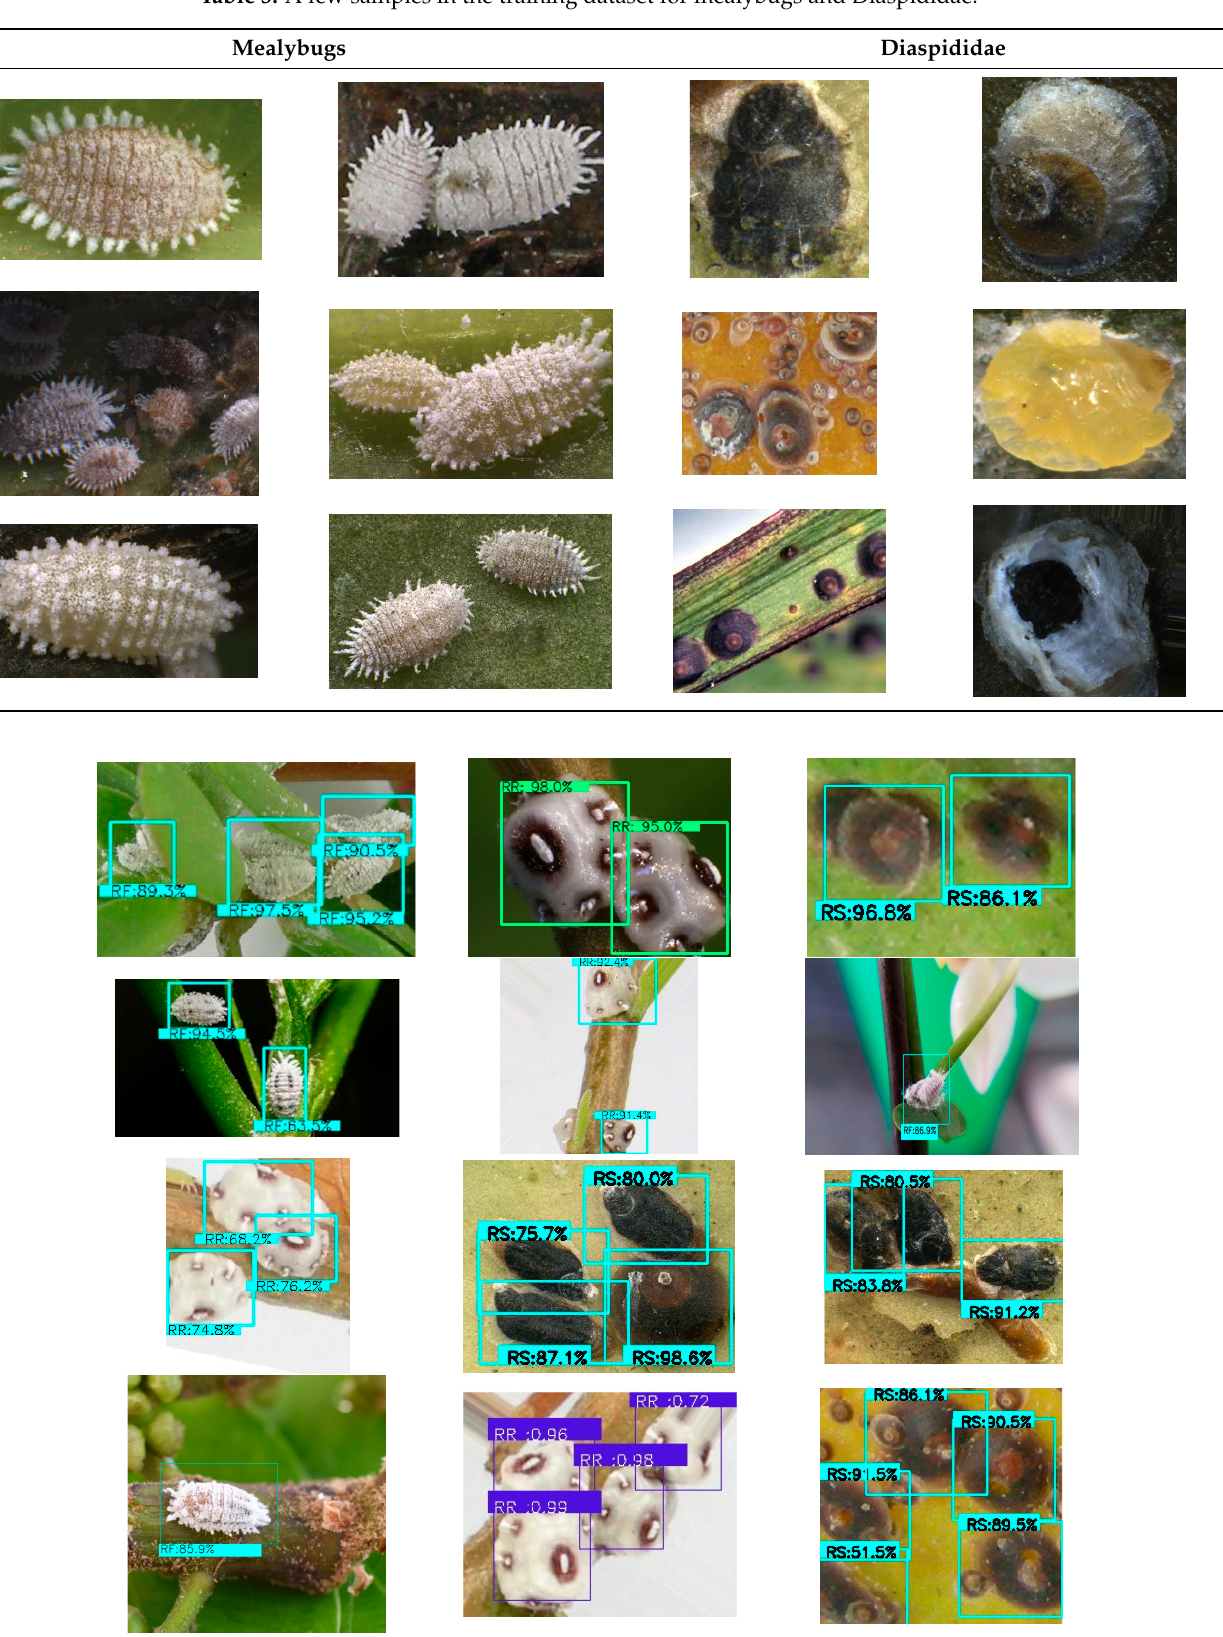
Table 3. A few samples in the training dataset for mealybugs and Diaspididae.